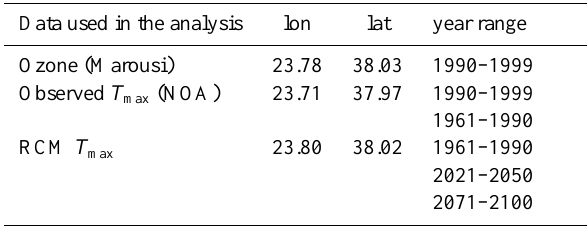
Table 1. List of the data used in the